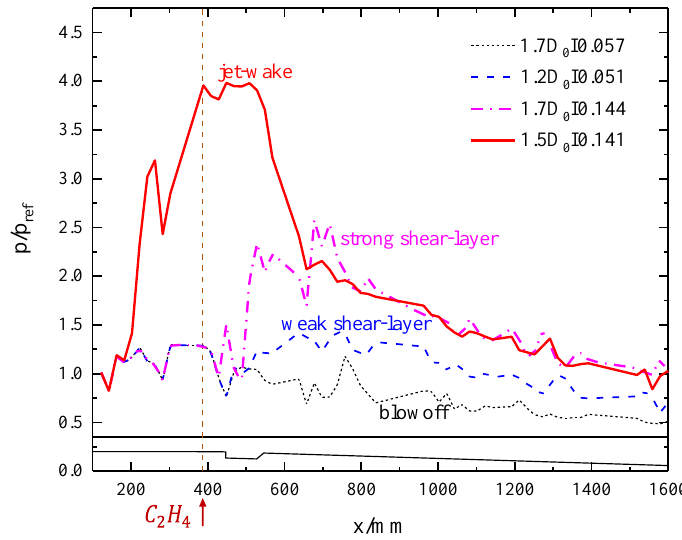
Figure 19. Dimensionless pressure along x axis to different injectors.